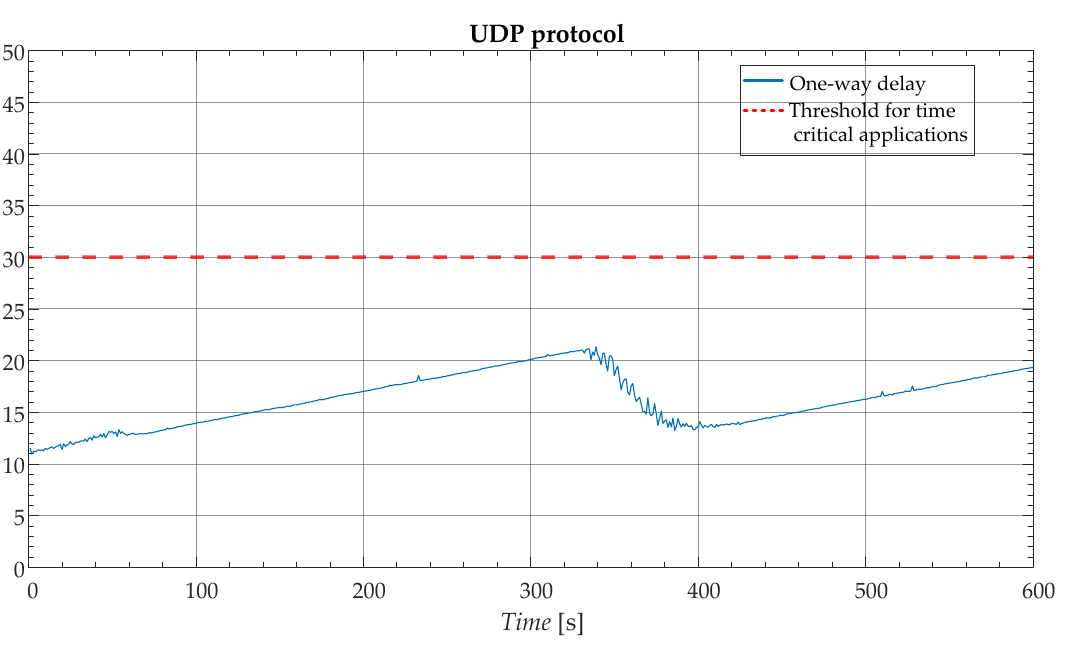
Figure 2. One-way delay for the user datagram protocol (UDP).